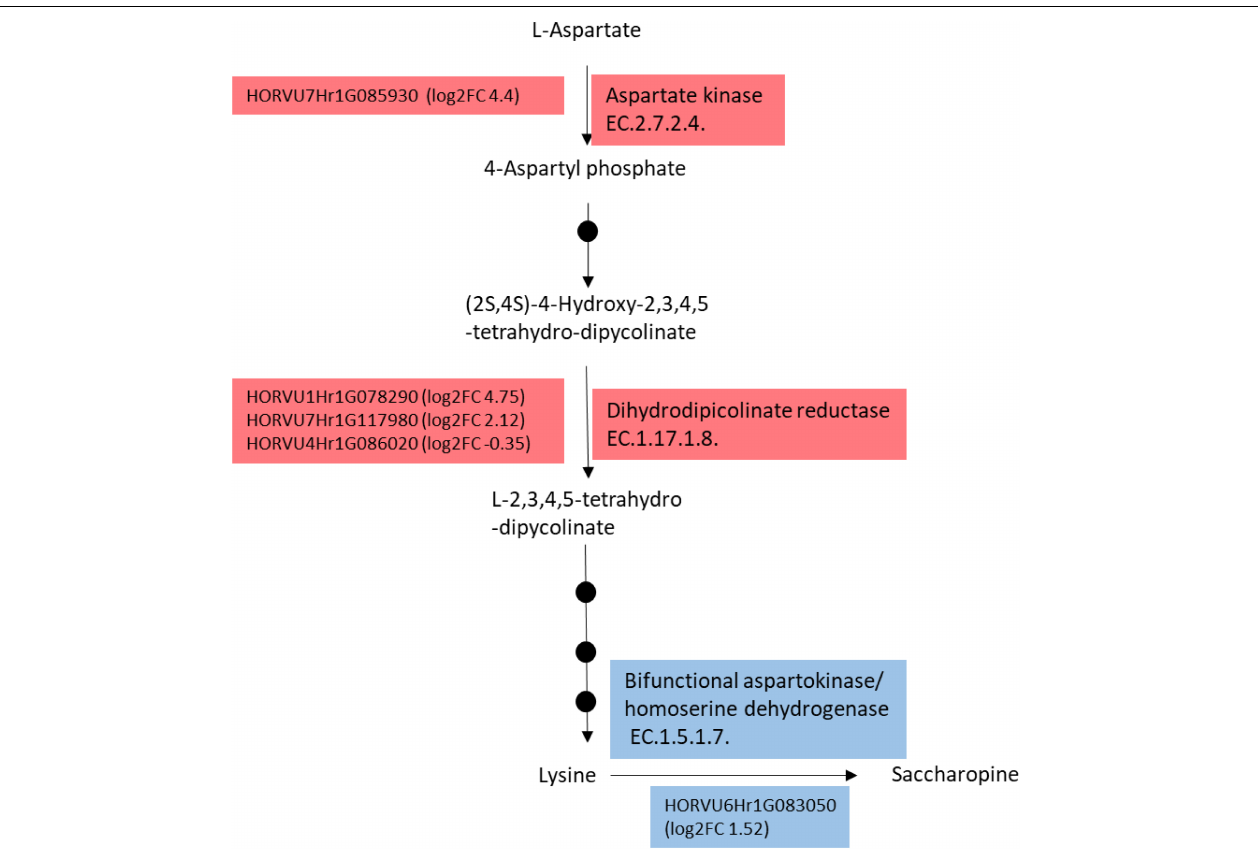
FIGURE 6 | Simplified Lysine biosynthesis and catabolism pathways were found to be differentially expressed in M4 compared to GP and M5. Genes encoding enzymes of these pathways are indicated with their accession numbers in front of the corresponding enzyme. For each gene, the log2 of the fold change (log2FC) corresponds to the expression in M4 compared to the mean of the gene expression level in M5 and GP. Red and blue boxes correspond to biosynthesis and catabolism of lysine, respectively. Black dots represent intermediate enzymatic steps that were omitted for simplification.